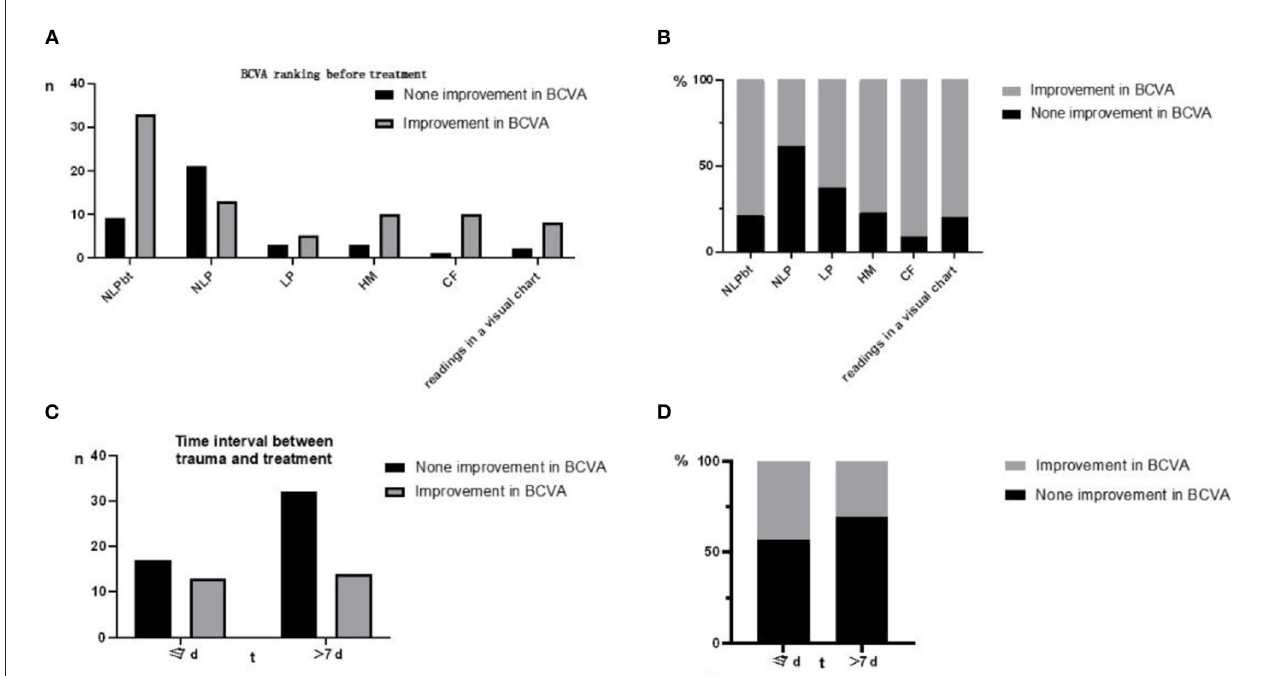
FIGURE3 (A) Distribution of preoperative visual acuity in TON patients. (B) The higher the preoperative visual acuity level, the higher the postoperative improvement rate. 78.6% of btNLP patients improved, which was higher than 38.5% of NLP patients. The difference between the two groups was statistically significant ( P < 0.001). (C) Interval between trauma and surgery in TON patient. (D) 66% of patients who underwent surgery within 7 days showed improvement, and 51.8% of patients who underwent surgery beyond 7 days showed improvement. No statistical difference was observed between the two groups.